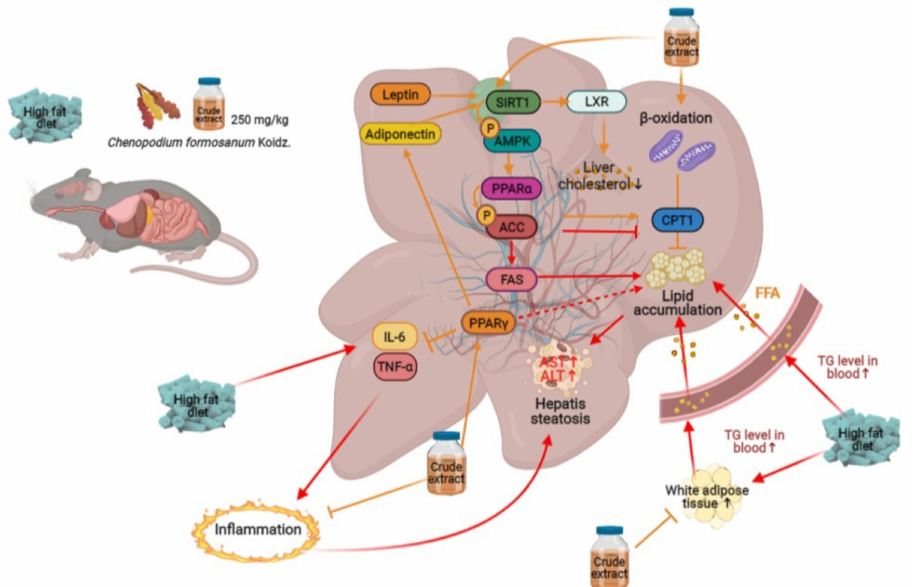
Figure 7. Proposed mechanism of Djulis hull crude extract-mediated modulation of the lipid metabolism pathway in HFD-induced obese mice. The effects of Djulis hull crude extract on the fatty liver of mice may occur through anti-inflammation and the lipid oxidative